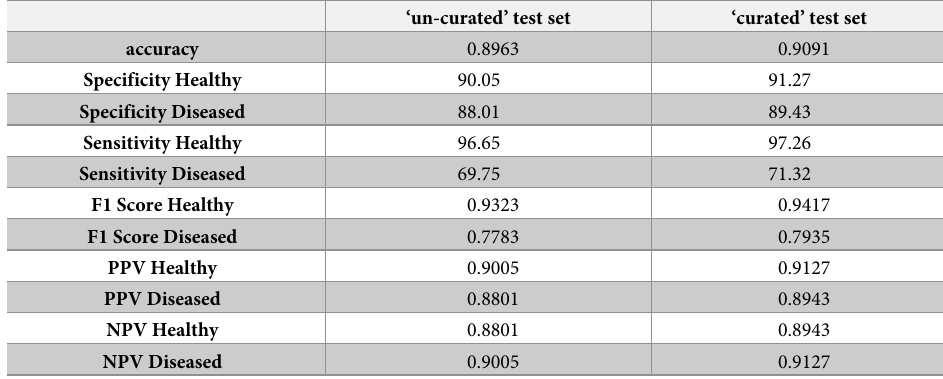
Table 4. Performance of the DRCNN based on two grades (healthy,